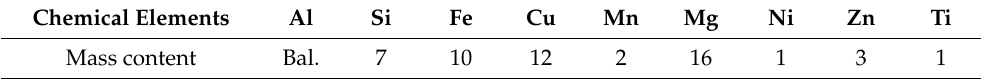
Table 1. Chemical composition of high-purity aluminum plates (mass content in ppm). Chemical